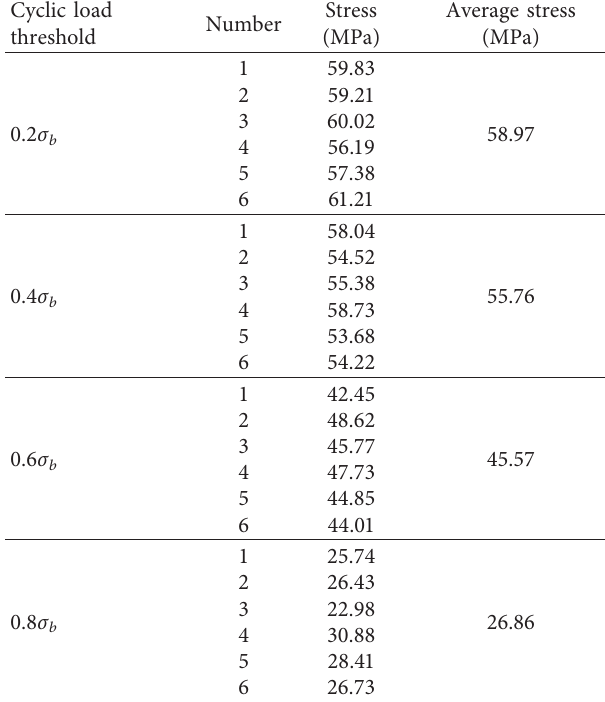
According to the results, the stress reduction ratio of damaged sandstone is 2.06%, 7.40%, 24.31%, and 55.39%, respectively, after 10 cycles of stress values of 0.2 σ 0.6 σ , and 0.8 σ , respectively. The uniaxial compressive b b strength of damaged sandstone decreases with the increase of the degree of damage, and the magnitude of the decrease gradually increases with the increase of the degree of damage. Fitting the cyclic load threshold ratio of the damaged sandstone to the strength reduction ratio is shown in Figure 6.